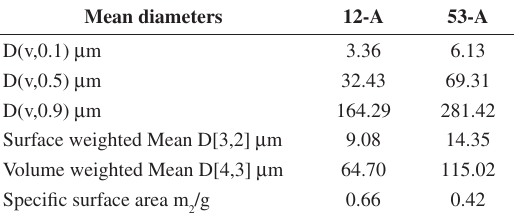
Table 2. Illustration of Malvern Statistical